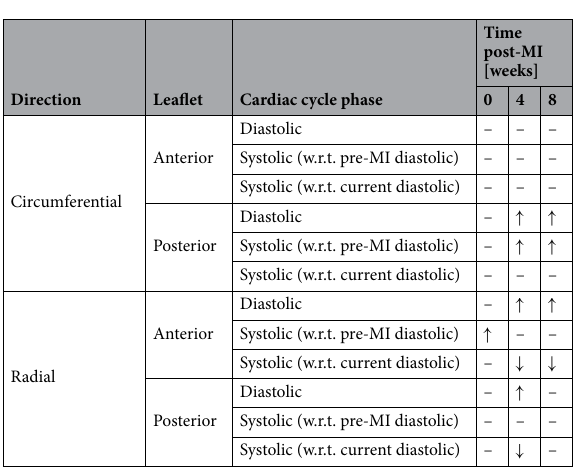
Table 1. Qualitative changes in directional stretches within the central regions of the anterior and posterior leaflet (segments A2 and P2). Arrows indicate whether the corresponding stretch is increased or decreased relative to its pre-MI value. Statistical significance was determined using a paired t -test for each segment, with a 95% confidence